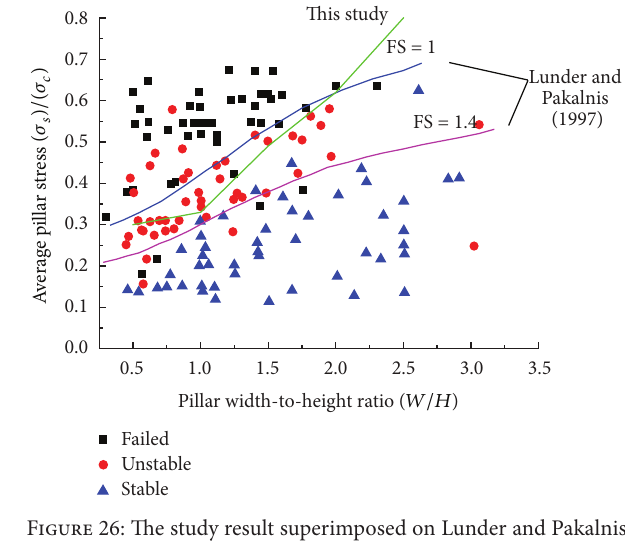
Figure 26: The study result superimposed on Lunder and Pakalnis [28] empirical design chart.